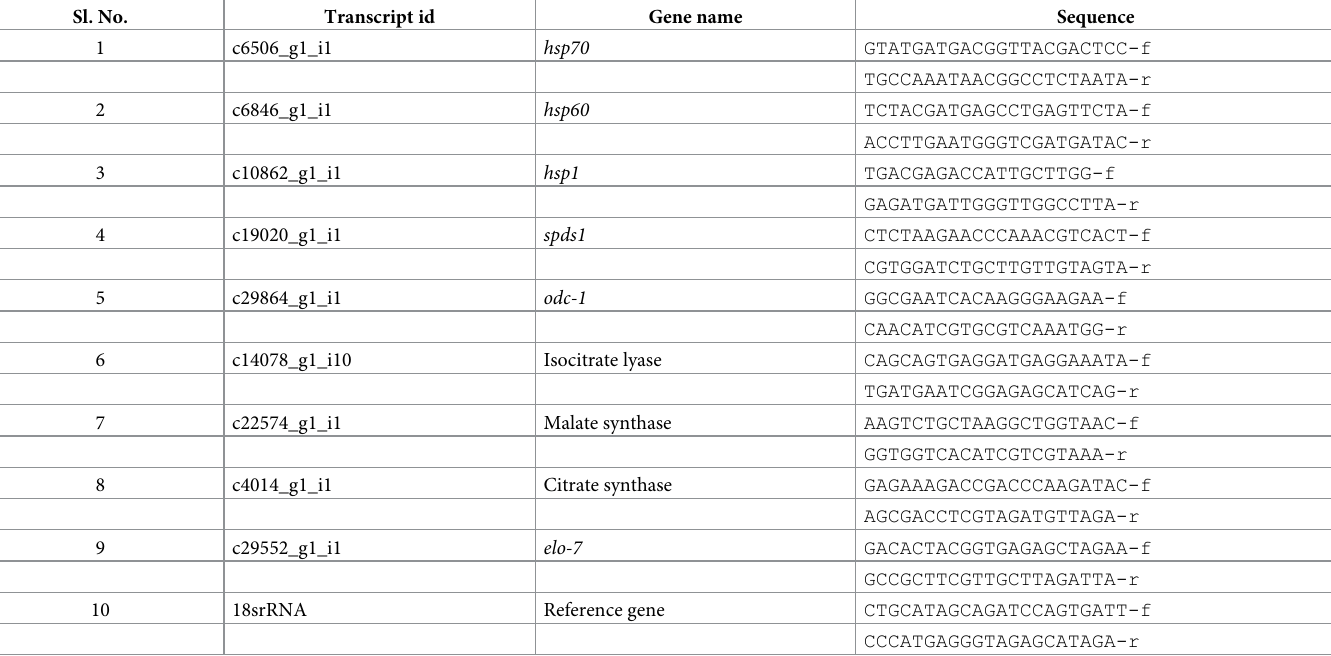
Table 4. List of primers used for the differential expression analysis through Real Time PCR. Sl.